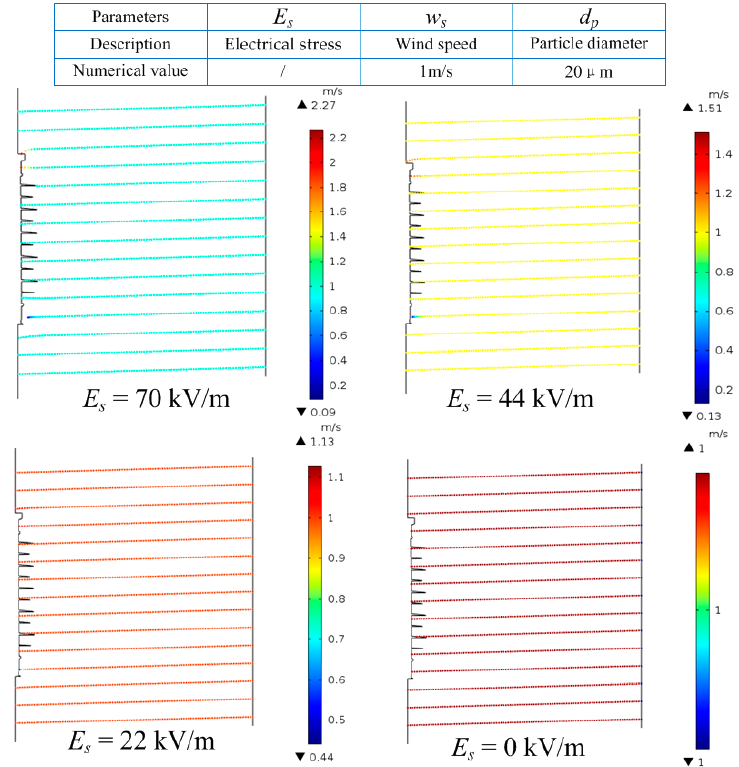
Energies 2019 , 12 , x FOR PEER REVIEW Figure 6. Particle movement under different electrical stress. Figure 6. Particle movement under di ff erent electrical stress.